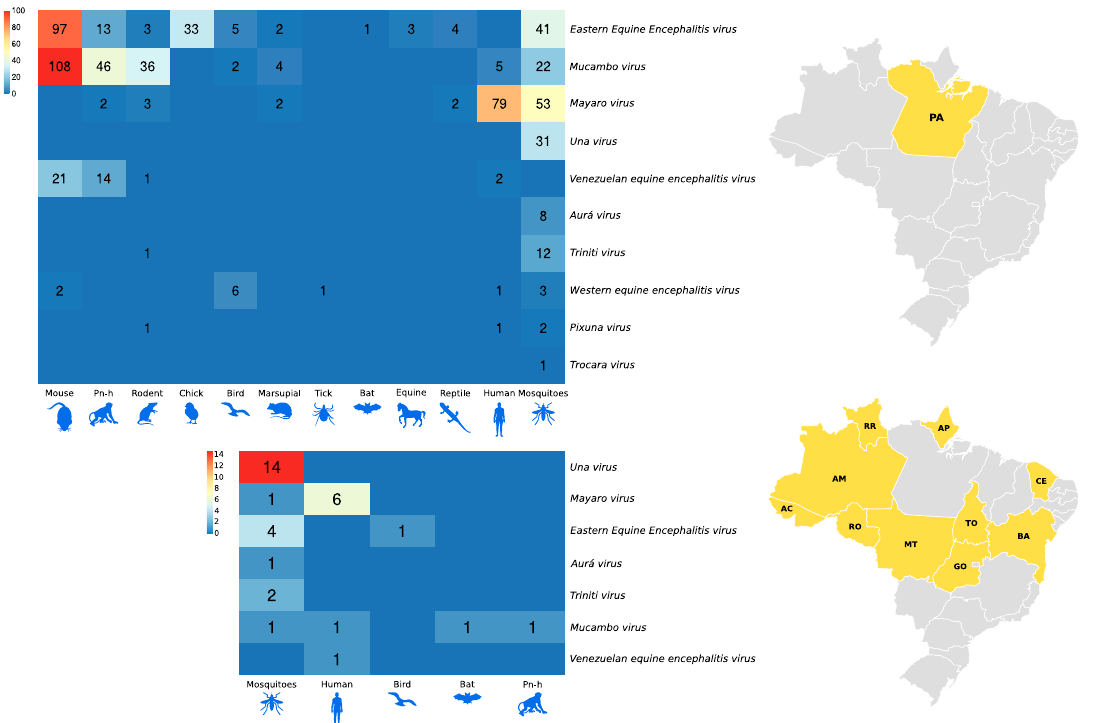
Figure 7. Distribution of alphavirus isolates in mice according to the animal model of origin. The larger heatmap is associated with isolates in the state of Pará. The smaller heatmap is associated with isolates from other Brazilian states.